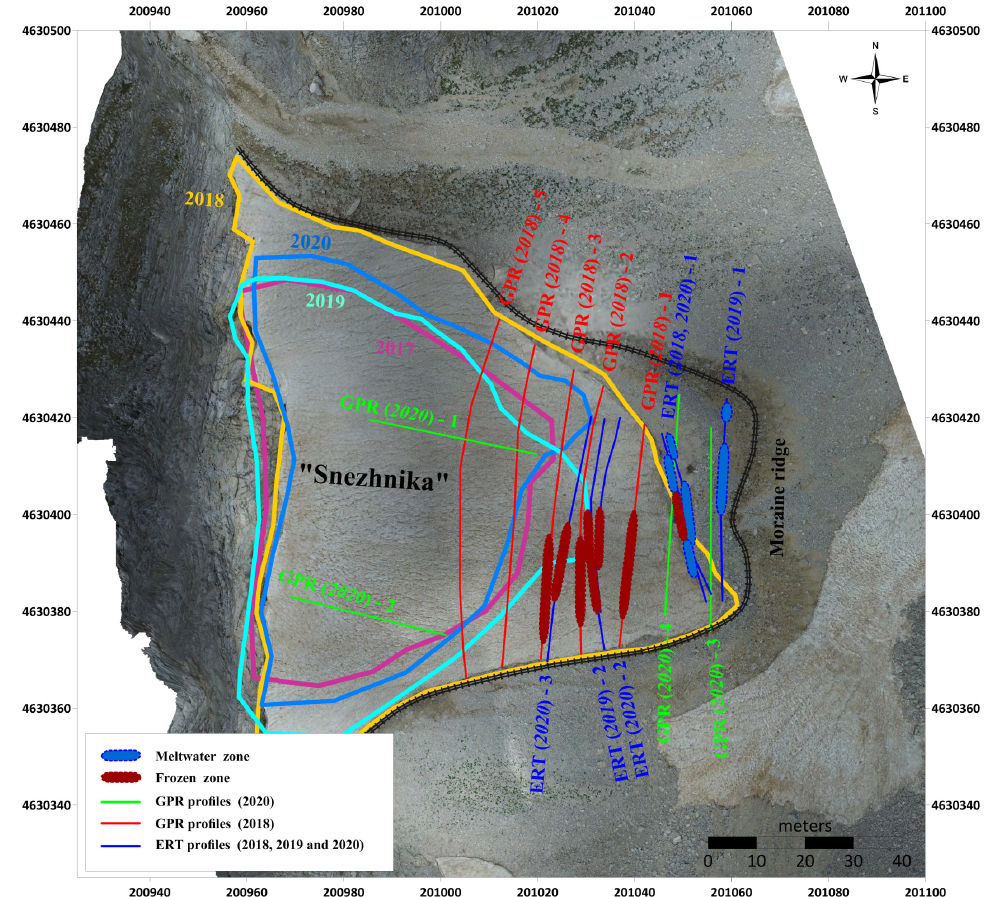
Figure 3. Location of all the GPR (red for 2018 and green for 2020) and ERT (blue) profiles in the Snezhnika area. The size of the glacieret between 2017 and 2020 is given with lines in different colors. Bold red lines show the position of the permafrost area, and bold blue lines show the location of meltwater (subsurface drainage system). The background picture, as well as the moraine ridge outline (black line), is made with the UAV in 2018 on the same day as the